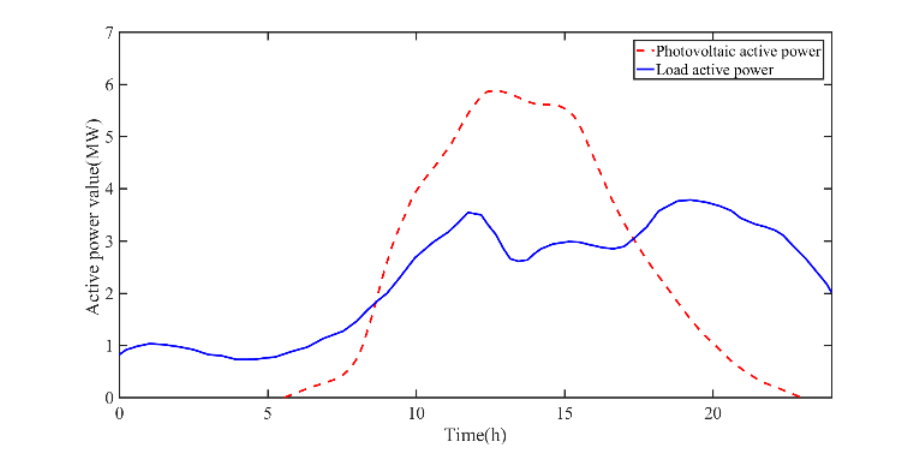
Fig. 5. System load and photovoltaic active power prediction curve.